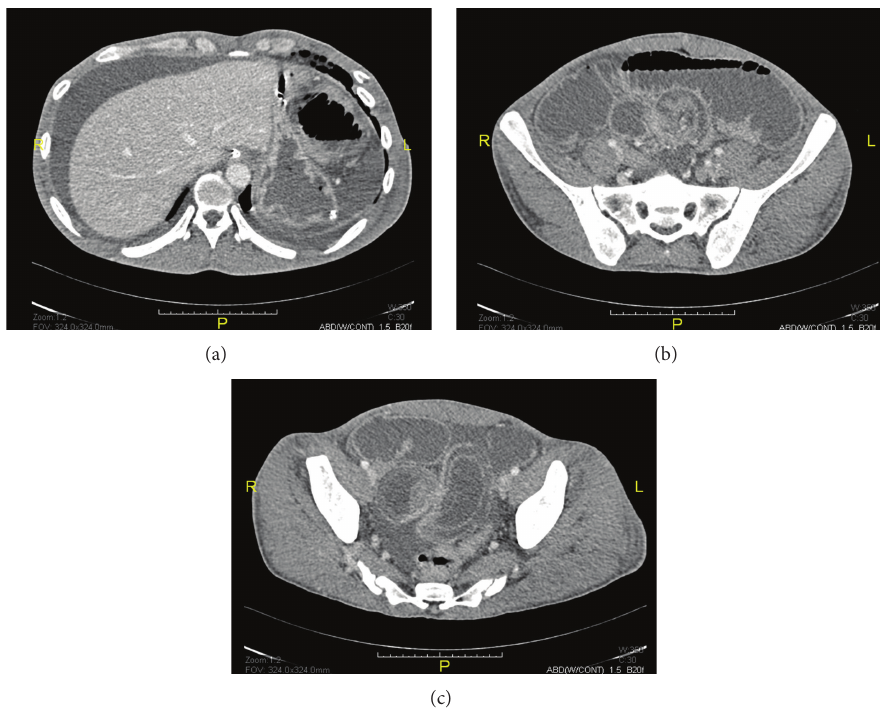
Figure 1: Abdominal CT scanning on day 9 of admission (day 5 after symptoms) showing peritoneal effusion, severely dilated small bowel, and suspected intussusception of the distal